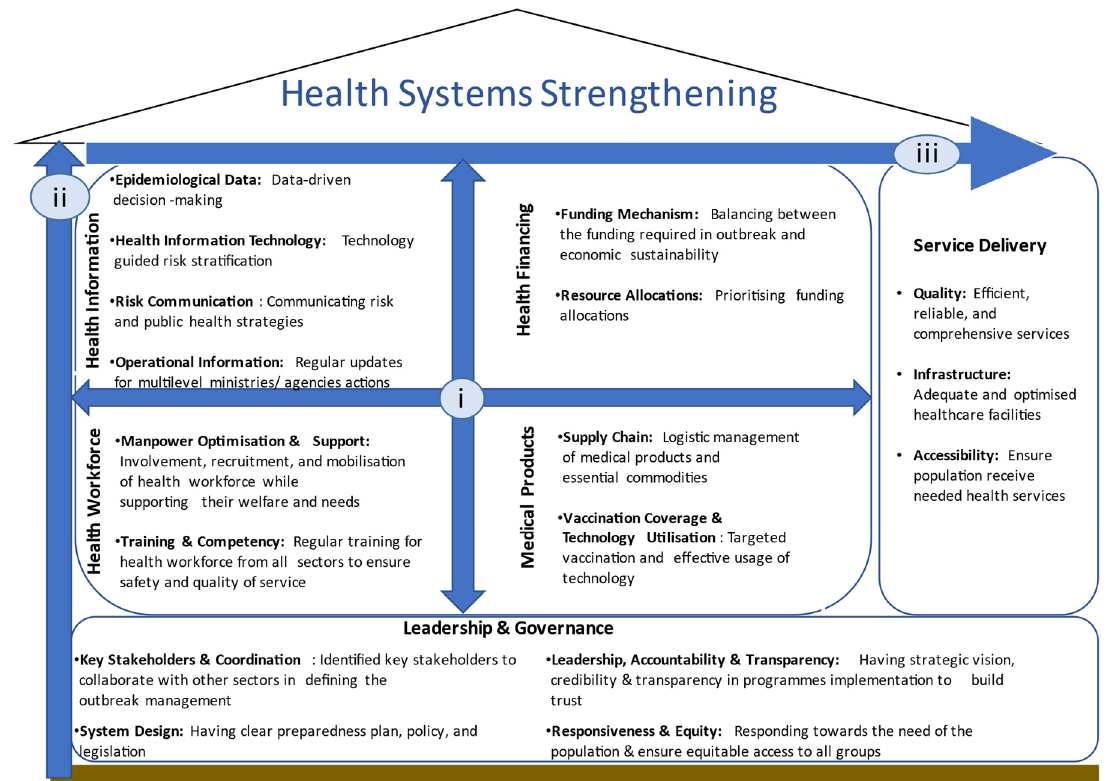
Figure 2. Complex interactions of health systems strengthening.